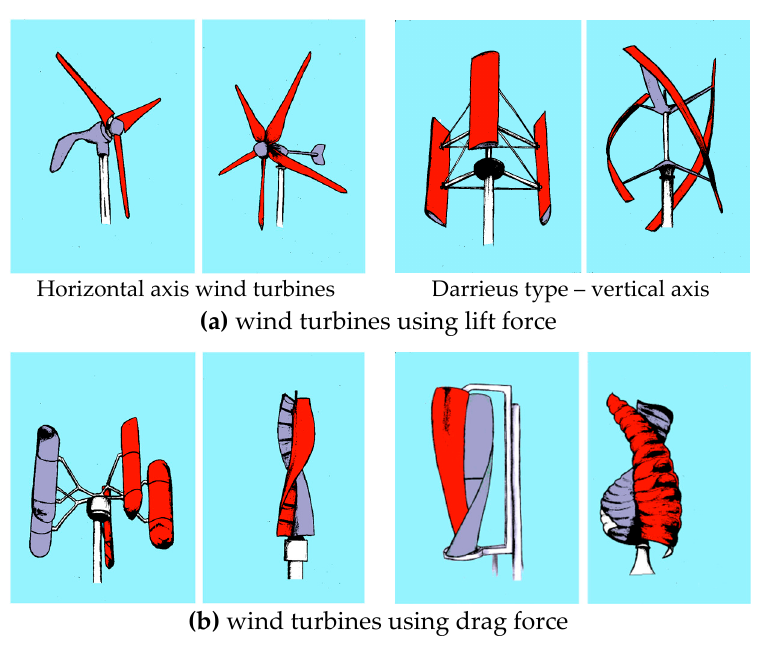
Figure 1. Different types of small wind turbines. Figure 1. Di ff erent types of small wind